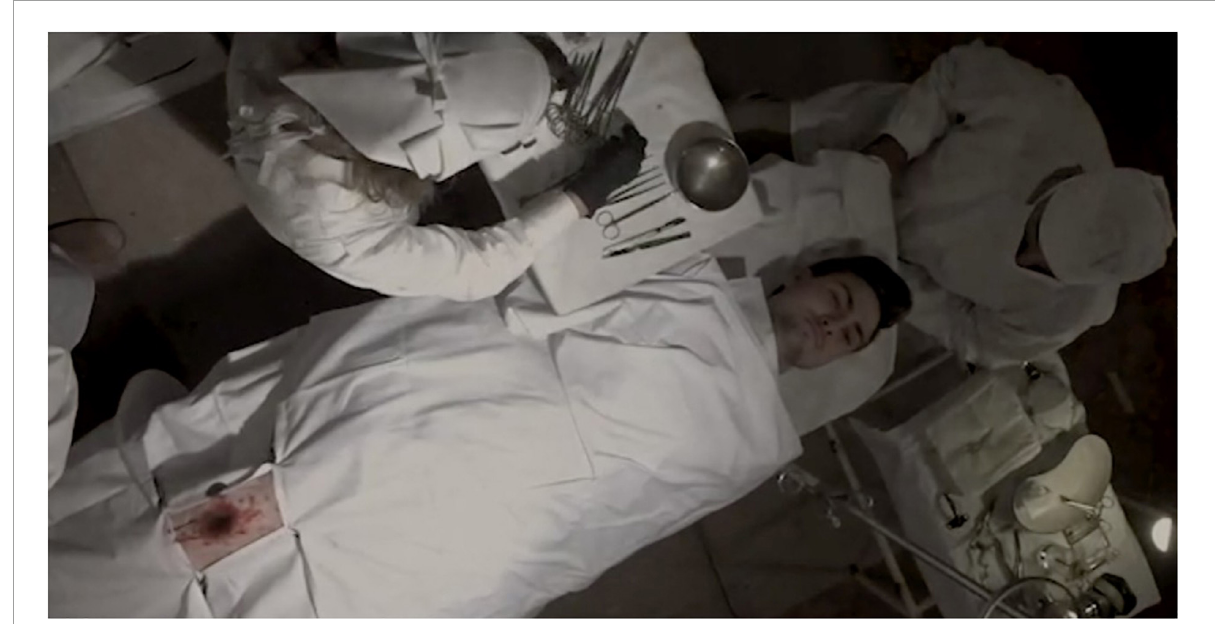
FIGURE5 Students of master’s studies in cultural and heritage management at the University of Barcelona in a film based on historical recreation for a hospital interpretation center during the Battle of the Ebro, during the Spanish Civil War. Frame of the video production of the surgical intervention. Zenith